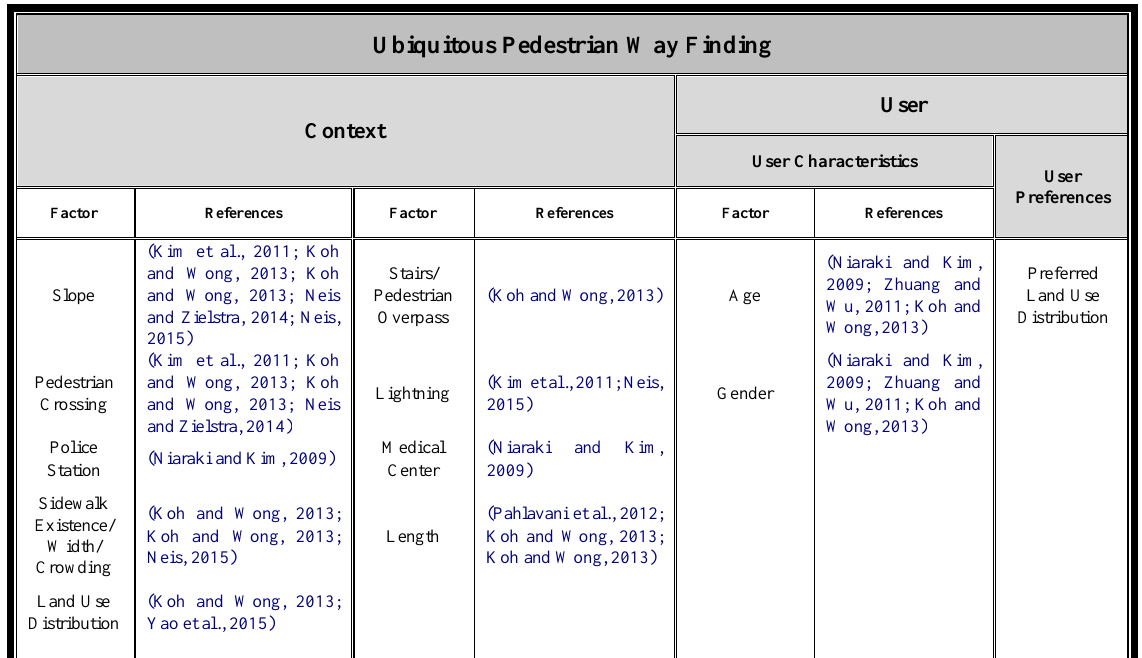
Table 1. UPWFS elements and its effective